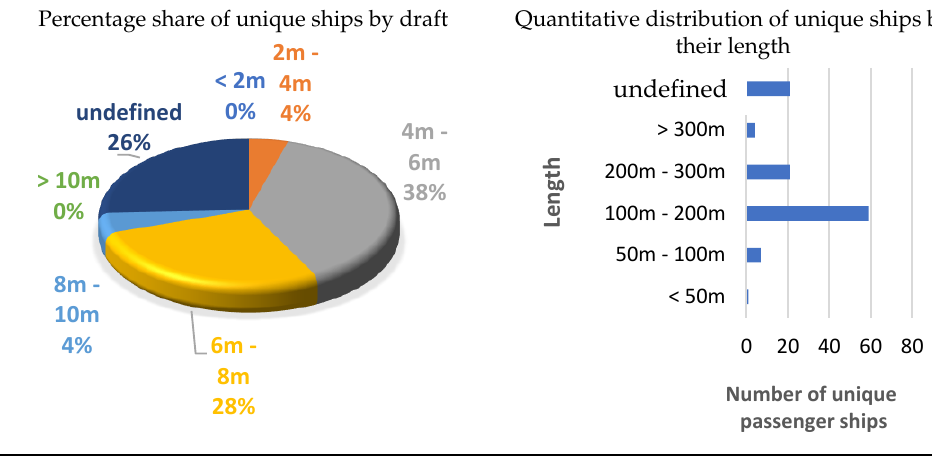
Table 5. Quality characteristics of passenger ships.